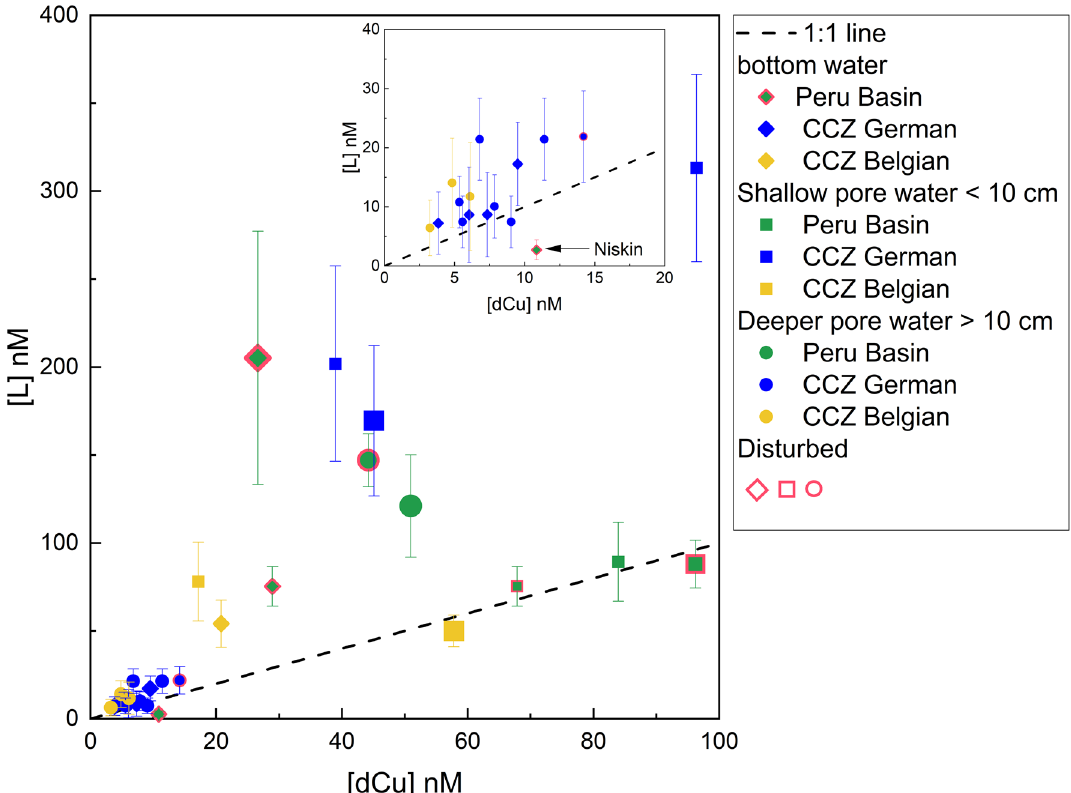
Figure 4. [dCu] vs. [L] of all samples for which [L] could be calculated (28 of 37 samples, 11 with ProMCC and 17 with Excel). ). Samples with a good ProMCC fit, that are most reliable, are plotted as bigger symbols. In samples that plot above the 1:1 line, L are present in excess of dCu and all Cu is presumably complexed by L. All samples plot within error range of the 1:1 line or above, except the ROV-Niskin sample from the Peru